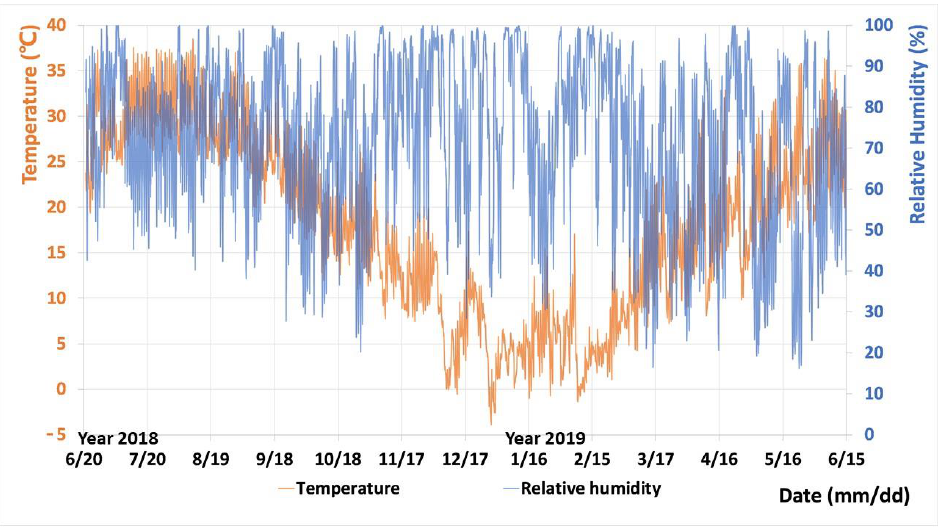
Figure 8. Temperature and relative humidity of Nanjing from June 2018 to June 2019, (source: weather station in Southeast University, Nanjing, China).